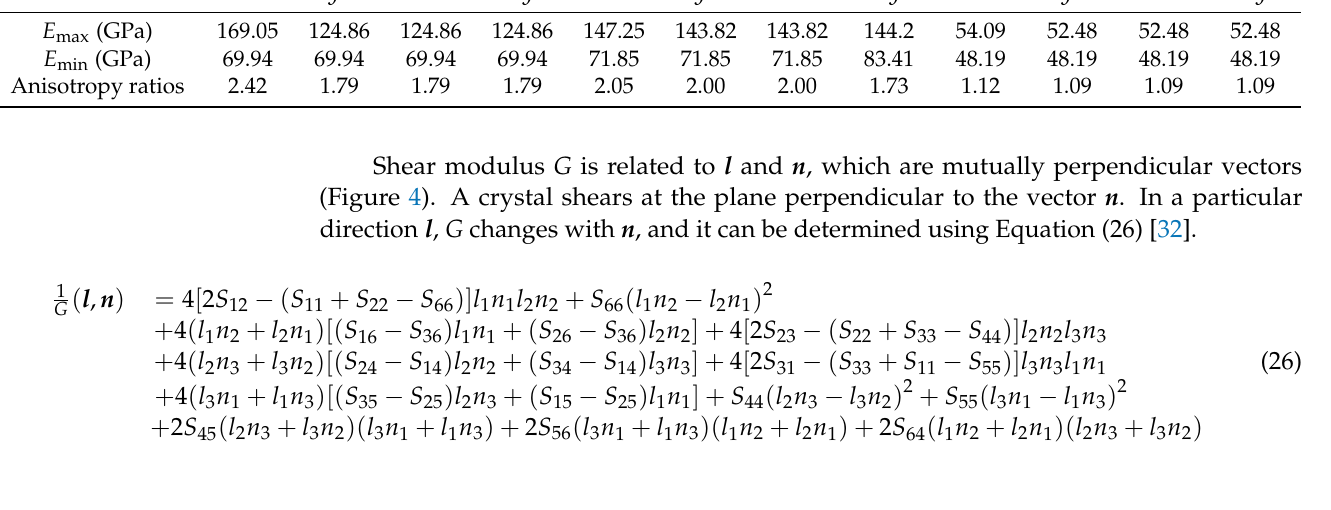
Figure 3. Cross-sections of Young’s modulus E on the ( a ) yz , ( b ) xz, and ( c ) xy planes of AuCu 3 , AuCu, and Au 3 Cu. Table 5. Anisotropy ratios and maximum and minimum Young’s moduli E for AuCu 3 , AuCu, and Au 3 Cu. AuCu 3 AuCu Au 3 Cu.